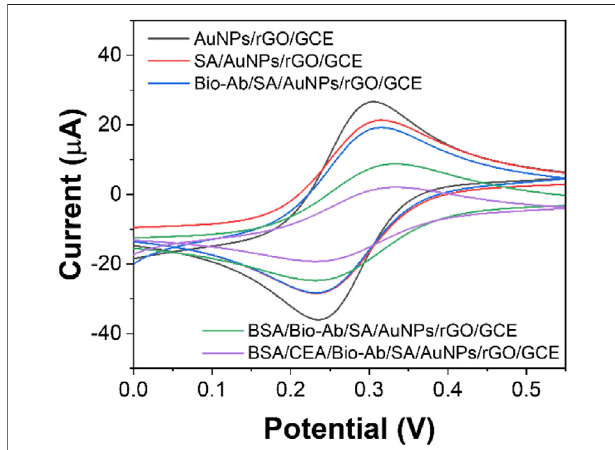
FIGURE 5 | CV curves of AuNPs/rGO/GCE, SA/AuNPs/rGO/GCE, Bio- Ab/SA/AuNPs/rGO/GCE, BSA/Bio-Ab/SA/AuNPs/rGO/GCE, and CEA/BSA/ Bio-Ab/SA/AuNPs/rGO/GCE.